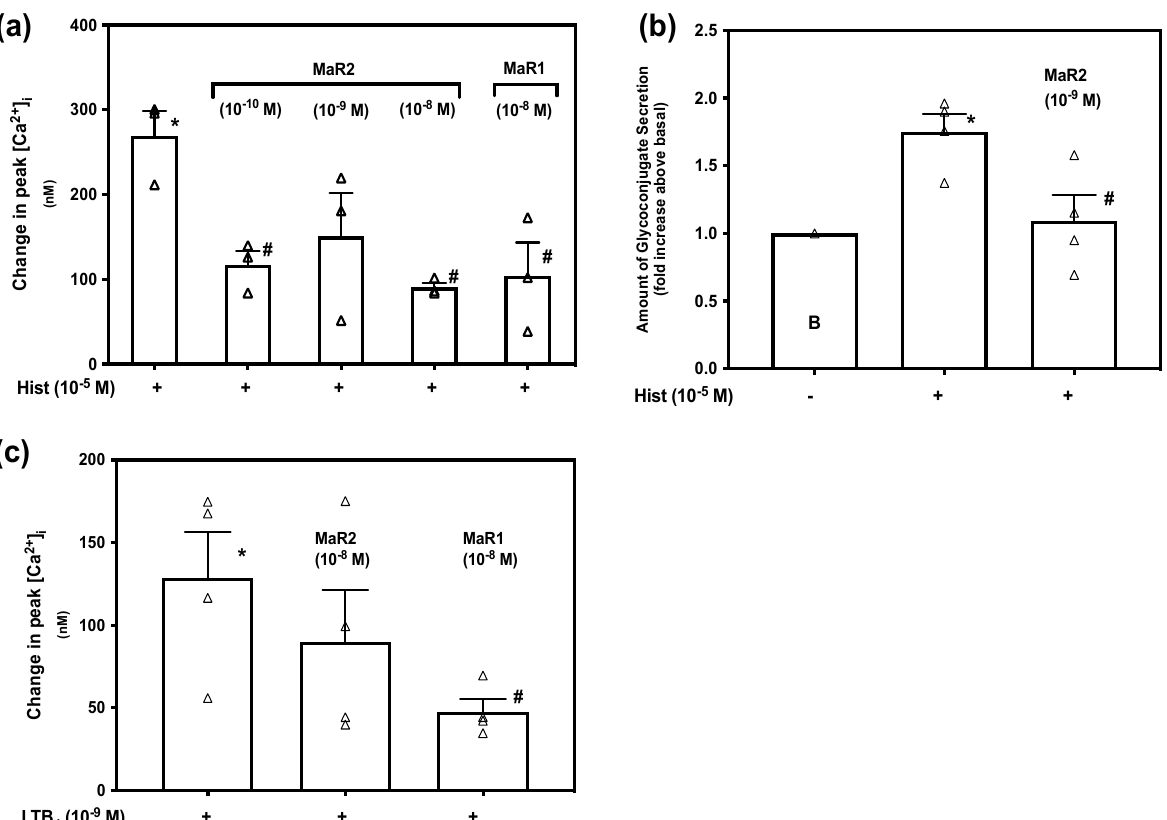
Figure 10. Maresin 2 inhibits histamine-, but not LTB 4 -stimulated increase in [Ca 2+ ] i and histamine- stimulated glycoconjugate secretion in rat conjunctival goblet cells. Goblet cells were incubated with MaR2 (10 − 8 M) and then stimulated with histamine (10 − 5 M). Goblet cells were incubated with MaR2 (10 − 10 to 10 − 8 M) or MaR1 (10 − 8 M) for 30 min, then stimulated with histamine (10 − 5 M). Changes in peak [Ca 2+ ] i are shown in ( a ) and changes in glycoconjugate secretion are shown in ( b ). Goblet cells were incubated with MaR2 (10 − 8 M) or MaR1 (10 − 8 M) for 30 min, then stimulated with LTB 4 10 − 9 M. Changes in peak [Ca 2+ ] i are shown in ( c ). Data are mean ± SEM of three ( a ) and four ( b ) and four ( c ) experiments. White triangles indicate individual data points. * shows significance above basal. # shows significance between MaR2 or MaR1 treatment and histamine ( a , b ) or LTB 4 ( c ) and histamine ( a , b ) or LTB 4 ( c ) alone. Dartt et al. demonstrated that histamine stimulates an increase in [Ca 2+ ] i and gly- coconjugate secretion in rat conjunctival goblet cells [34]. To investigate if MaR2 inhibits histamine stimulated glycoconjugate secretion, rat conjunctival goblet cells were prein- cubated with MaR2 (10 − 8 M) for 30 min prior to stimulation with histamine (10 − 5 M). Histamine stimulated secretion to 1.75 ± 0.13 above basal ( p = 0.001, Figure 10b; n =